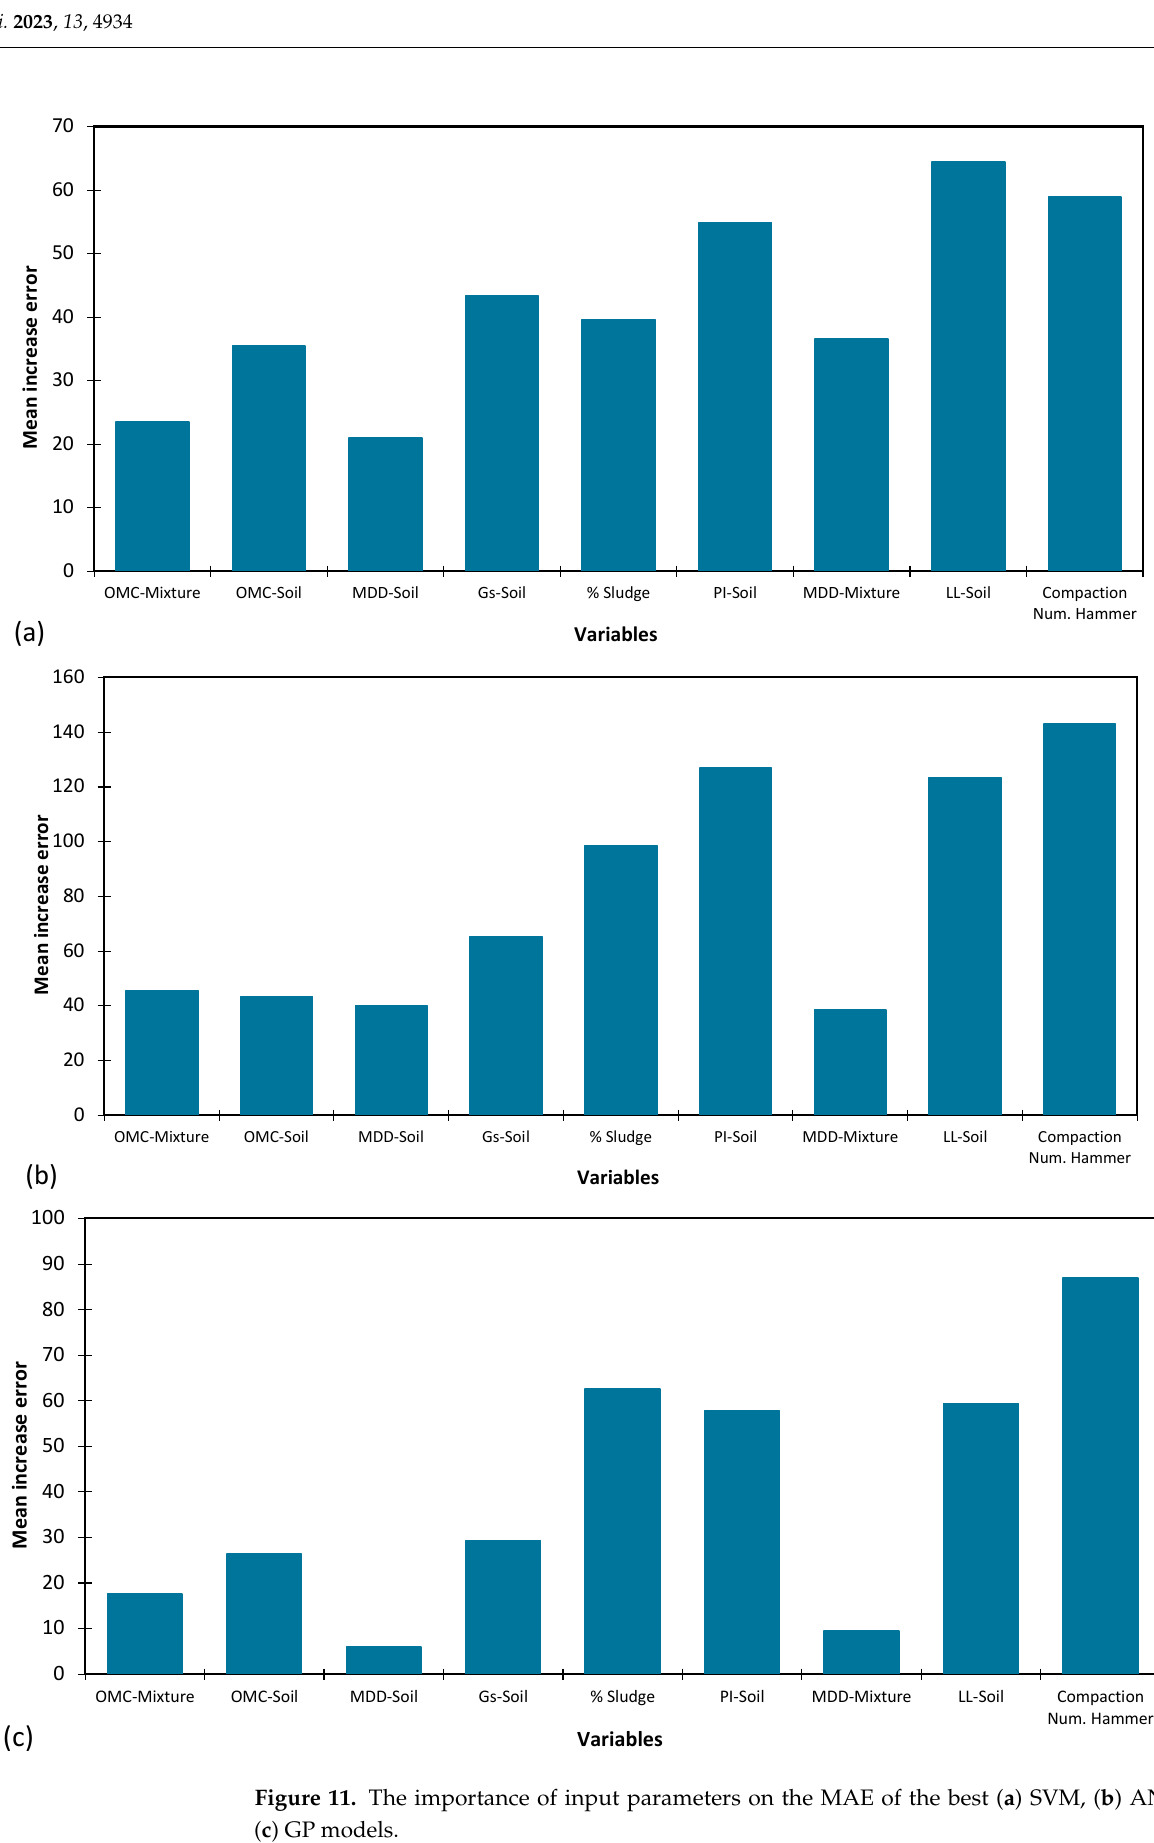
Figure 11. The importance of input parameters on the MAE of the best ( a ) SVM, ( b ) ANN, and ( c ) GP models.